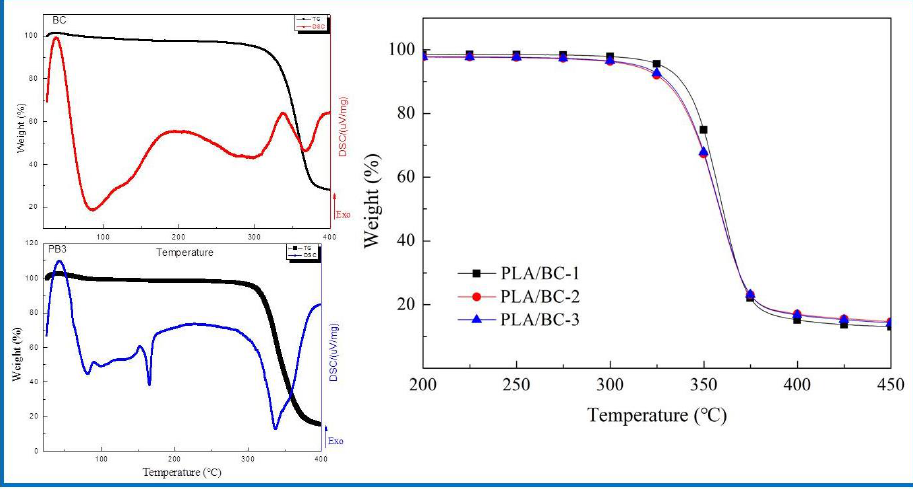
Figure 5. Analysis of thermal properties of BC membrane and PLA/BC composite scaffolds.